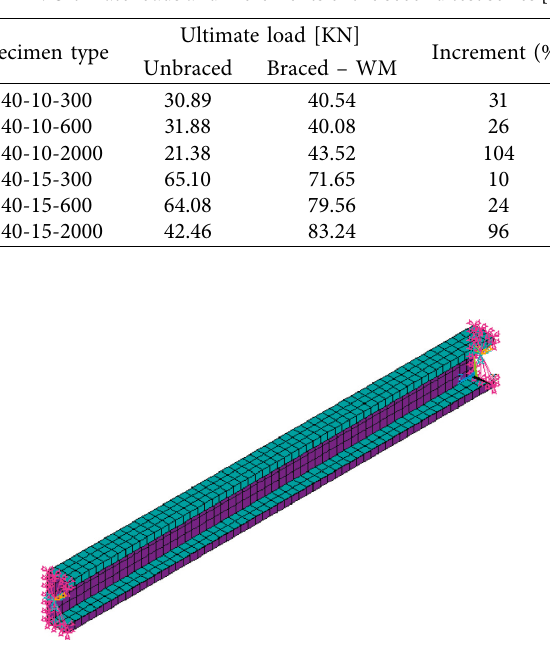
Figure 5: Applied loads and boundary conditions of the 600mm